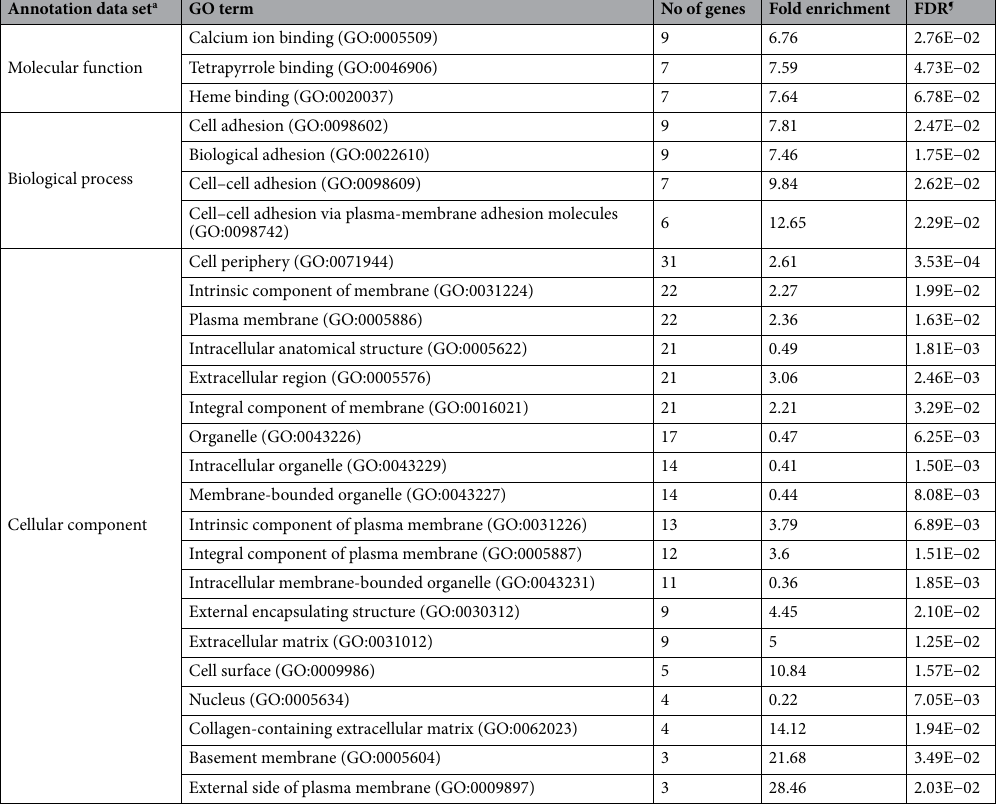
Table 4. PANTHER gene ontology (GO) enrichment analysis of downregulated genes. Displaying only results for FDR P < 0.05. ¶ p-value from Fisher’s exact test with false discovery rate (FDR) correction for multiple testing. a PANTHER GO-Slim